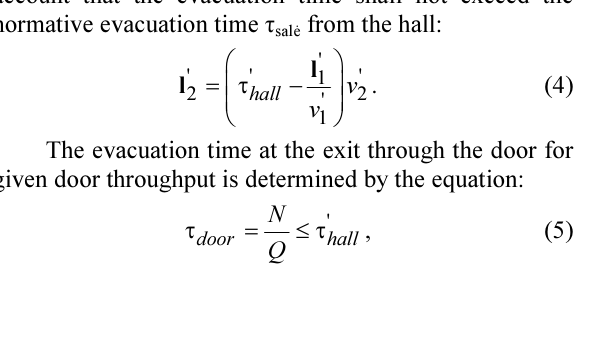
Intensity q , m/min.